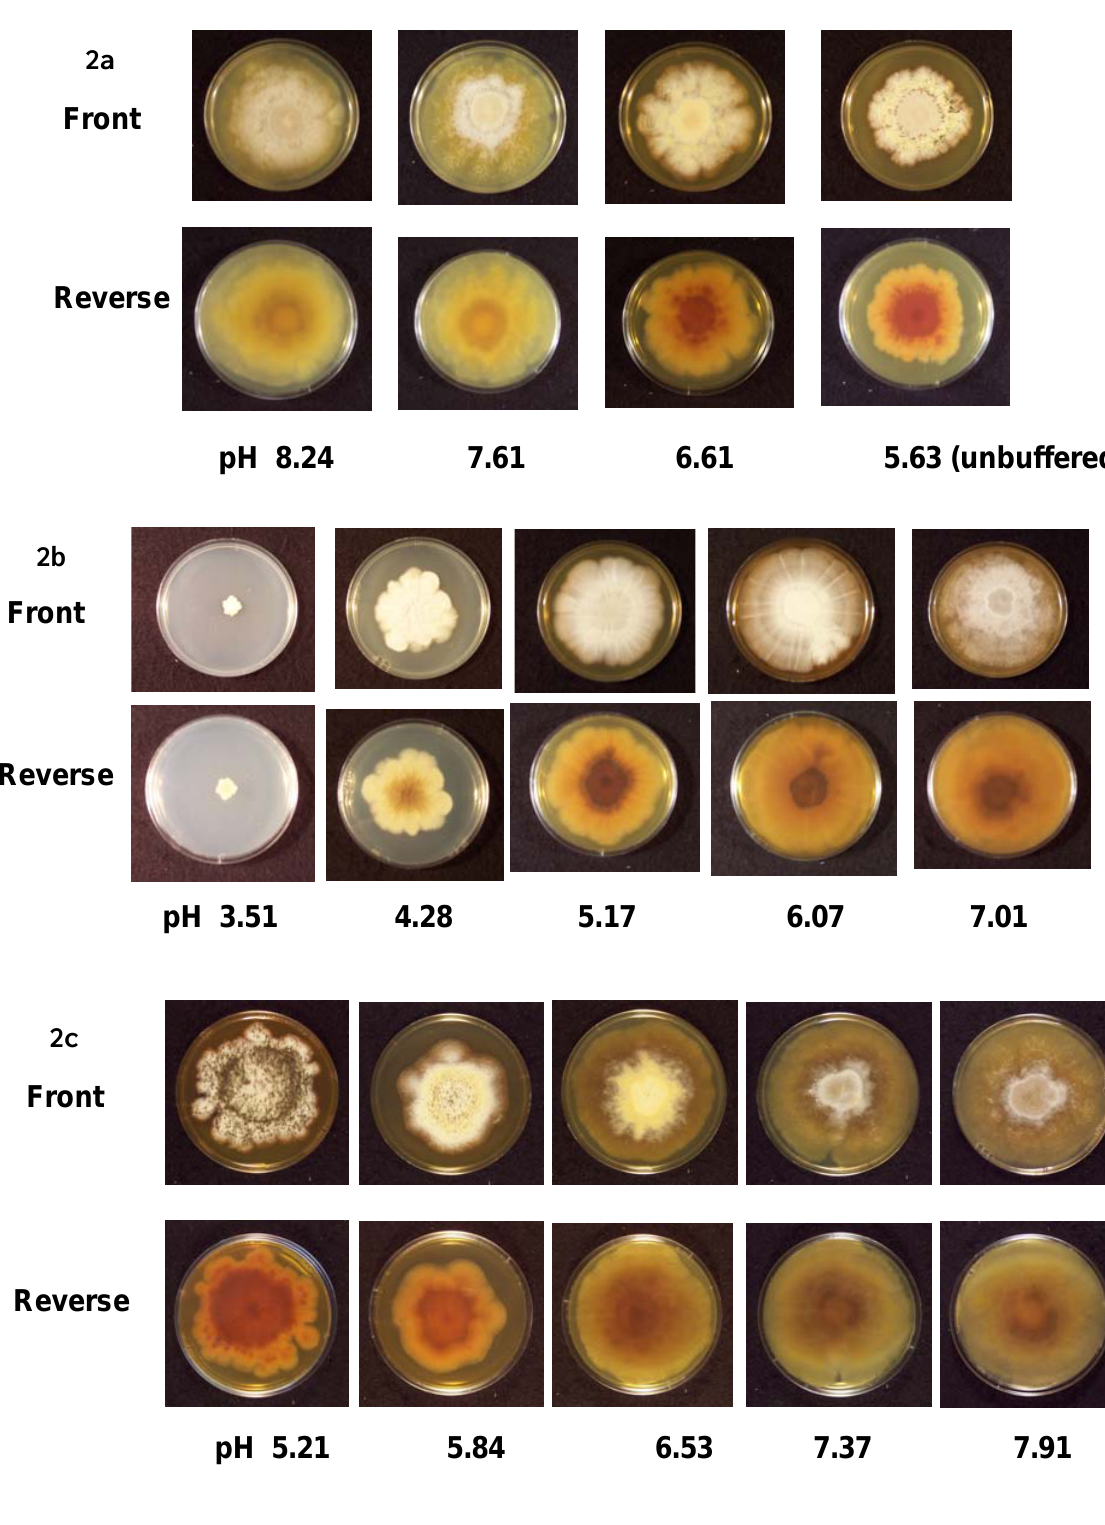
Figure 2 . Photographs of C. globosum colonies at 4 weeks on Tris buffered and unbuffered potato dextrose agar (a), on citrate-phosphate buffered potato dextrose agar (b) and on Tris-maleate buffered potato dextrose agar (c). The center of each agar plate was inoculated with 500 C. globosum spores suspended in 20 μ L of water. These photographs depict the front and reverse sides of agar plates with C. globosum colonies after four weeks of incubation at room